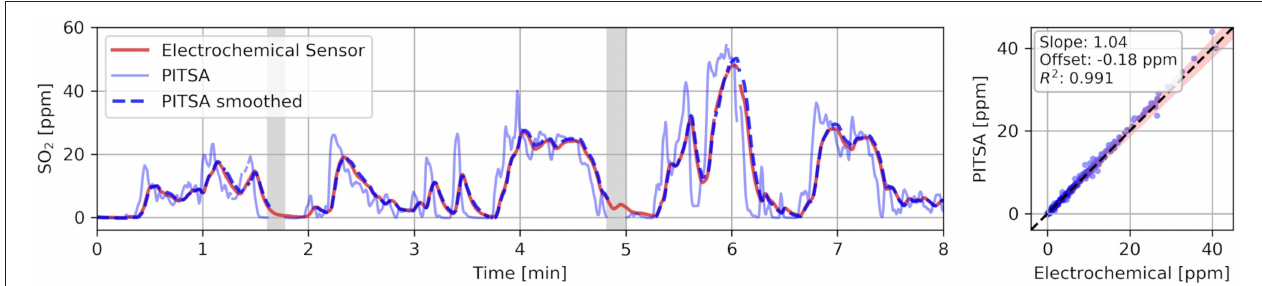
FIGURE 10 | Parallel measurements of the PITSA and a freshly calibrated electrochemical sensor on the rim of Mt. Etna. Gray shaded areas mark PITSA data gaps due to zero point measurements. Left : Excerpt of the time series. After artificially degrading the PITSA’s response time, the two instruments are in good agreement. Right : Scatter plot of 10s average values. Darkness of points represents the data point density. The red shaded area indicates the uncertainty of the electrochemical sensor as specified by the supplier.